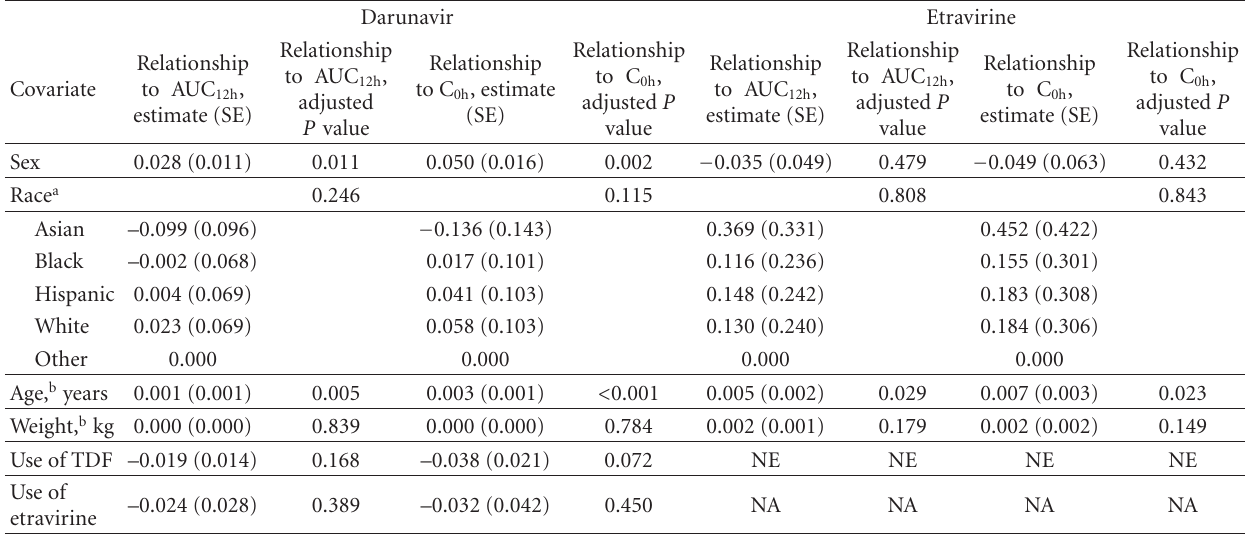
Table 3: Relationship of selected covariates with darunavir or etravirine pharmacokinetic parameters at Week 48—analysis of